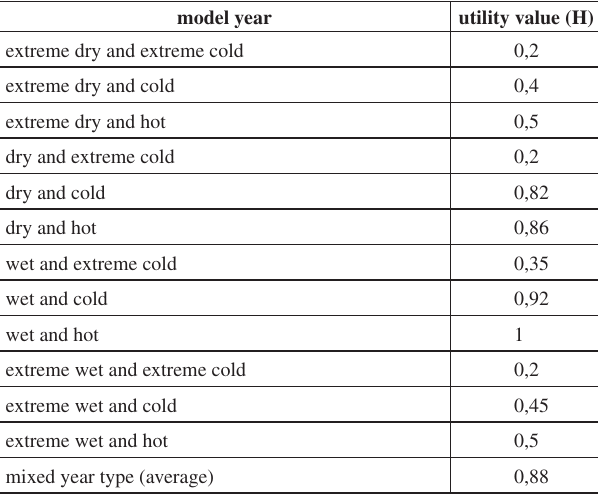
Table 4. Climatic year types and their utility values in case of sour cherry